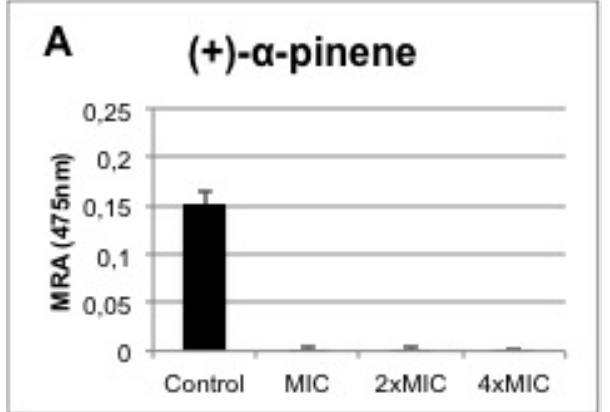
Figure 4. Effect of (+)-  -pinene ( A ) and (+)- β -pinene ( B ) standards on the mitochondrial two- and four-fold MIC concentrations. The results represent the mean ± standard error of inhibition of biofilm viability; * p <